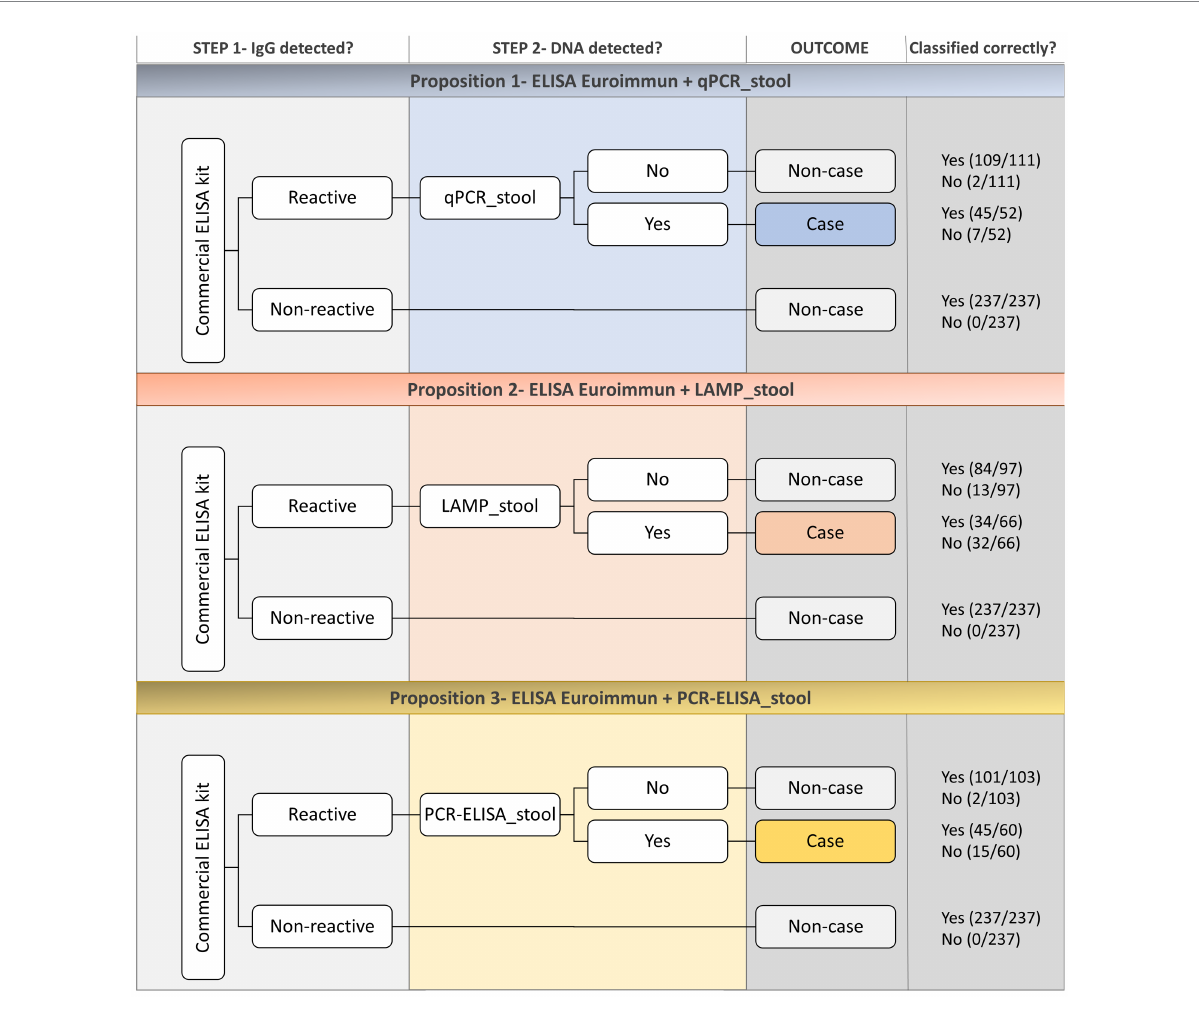
FIGURE 3 Flowchart illustrating the three different two-step diagnostic approaches proposed for the active search of infected people in endemic